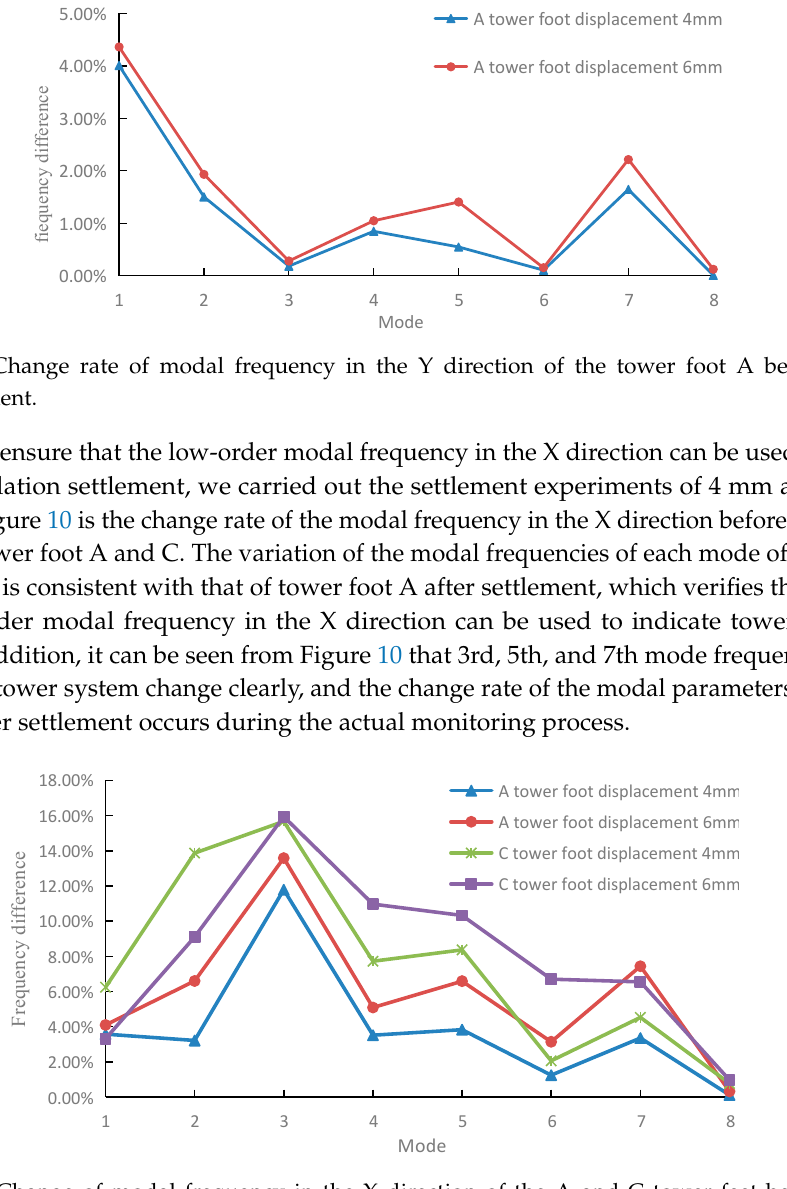
9 of 16 Table 3. Average modal frequency and change rate in the X direction of tower foot A before and after settlement. Settling 0 mm ( 0  )